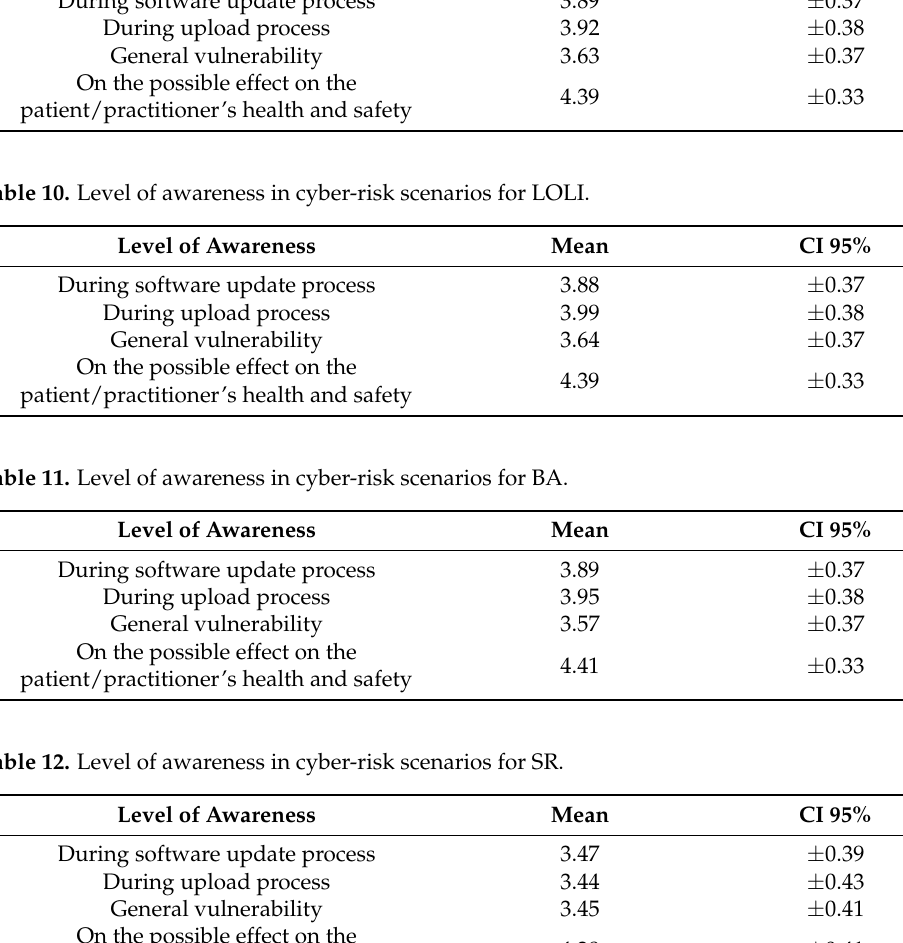
Table 9. Level of awareness in cyber-risk scenarios for UPLI. Level of Awareness Mean CI 95% During software update process